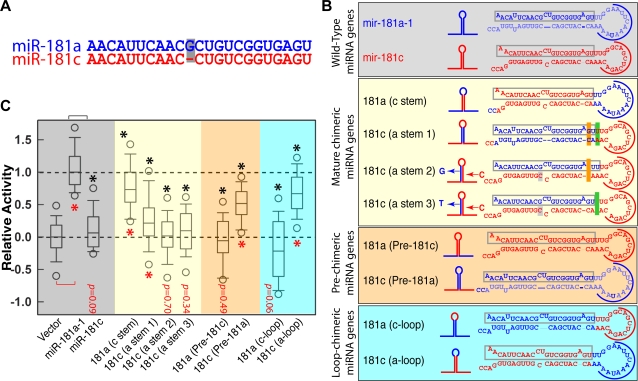
The pre-miRNA loop nucleotides control the distinct activities of mir-181a-1 and mir-181c on DP cell development.(A) Nucleotide sequences of mature miR-181a and miR-181c. (B) Schematics and nucleotide sequences depicting the wild-type mir-181a-1 and mir-181c genes and corresponding precursors (shaded grey). Also shown are the chimeric miRNA genes, with the mature miRNAs, pre-miRNAs, and pre-miRNA loops swapped between mir-181a-1 and mir-181c, termed “mature-chimeric” (shaded yellow), “pre-chimeric” (shaded orange), and “loop-chimeric” (shaded blue), respectively. These mutant genes are designated as 181a(c stem), 181c(a stem), 181a (pre-181c), 181c (pre-181a), 181a (c-loop), and 181c (a-loop). Similar color codes are used in all figures. (C) The effects of the chimeric mir-181a-1/c genes on DP cell development. Normalized data from 3–7 independent T cell assays (each with 12 independent replicates for a total of 36–84 replicates) are pooled and graphed in the distribution box plots. Mann-Whitney Rank Sum Tests were performed (
Table S2
 for statistics) to determine whether the activities of the chimeric miRNA genes are statistically different from those of the negative control vector (red *, p<0.0001) and/or mir-181a-1 positive control (black *, p<0.0001). A representative OP9-DL1 stromal co-culture assay without normalization is also shown (
Fig. S6
).